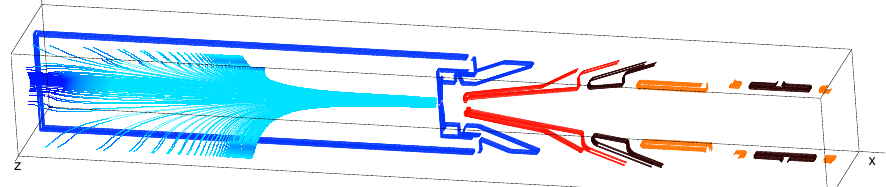
Figure 6. Projection of magnetic field lines going through the extraction aperture.